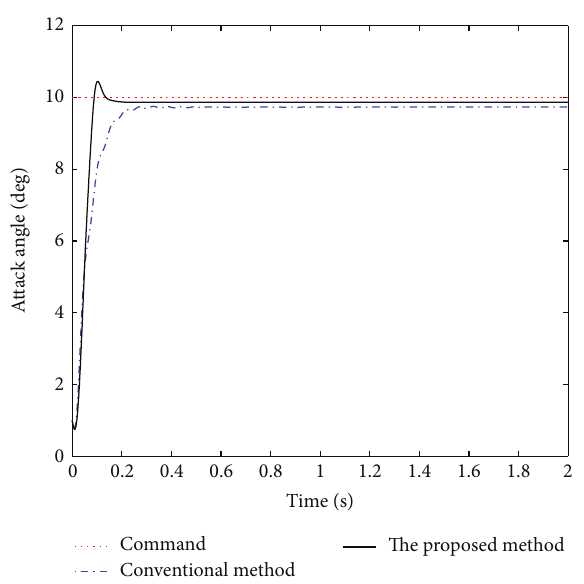
Figure 2: Curves of attack angles under the two control schemes.